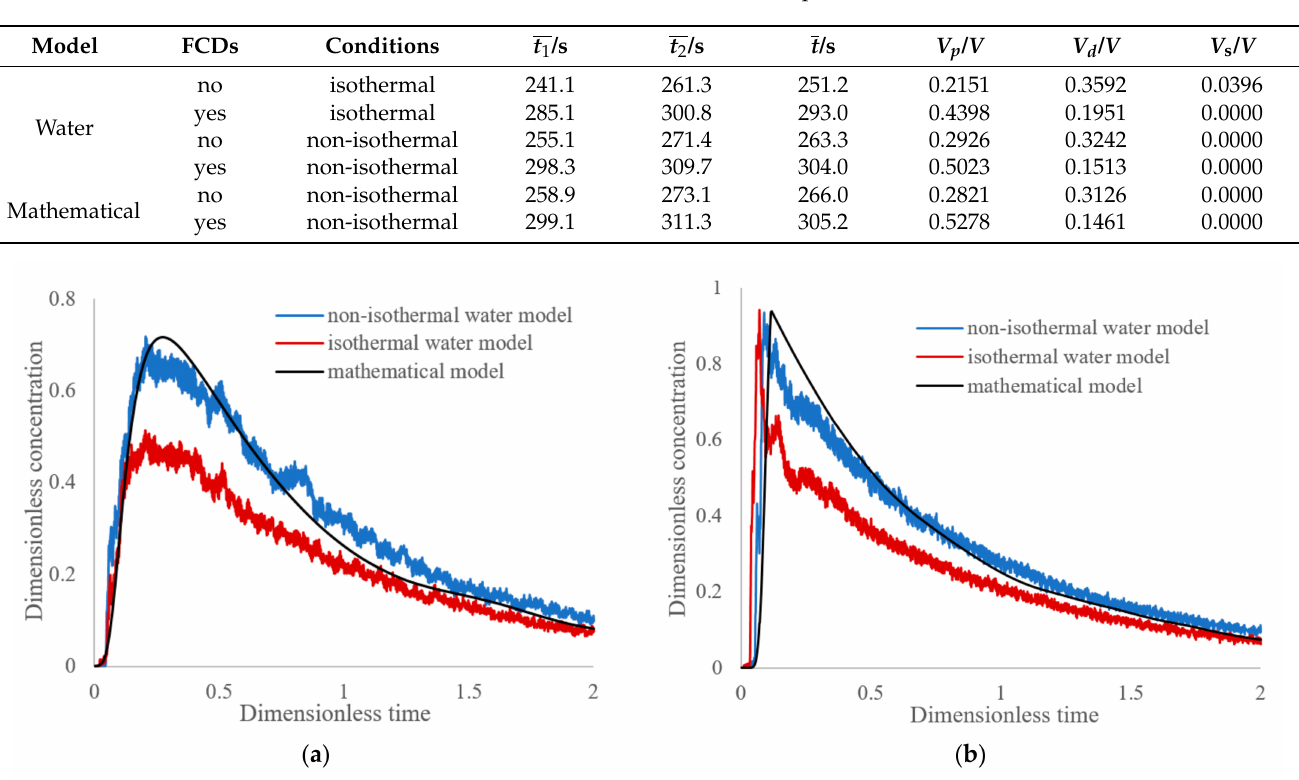
Table 4. The measured residence times and flow patterns of molten steel in the tundish.